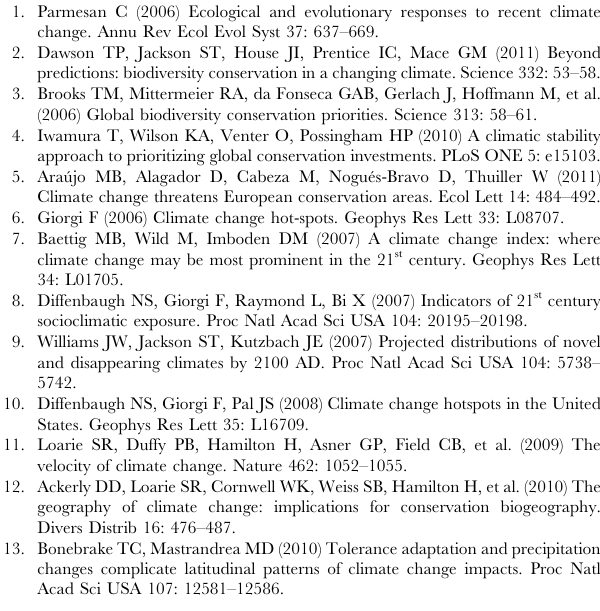
Table S2 Observed and projected RCCI for 196 G200 ecoregions. The observed RCCI (RCCI obs ) is based on differences in climate conditions between 1961 2 1980 and 1991 2 2009, generated from Climate Research Unit (CRU) TS 3.1 datasets; the projected RCCI is based on differences in climate conditions between 1991 2 2010 and 2081 2 2100, generated from an ensemble of 62 GCM 6 GHG emission scenario combinations. The relative magnitude of projected RCCI is measured by the multi-model mean RCCI (RCCI mean ) and the proportions of GCM 6 GHG emission scenario combinations with RCCI $ 12 (the 50 th percentile of RCCI obs ) and RCCI $ 16 (the 80 th percentile of RCCI obs ), respectively (abbreviated as Fr.(RCCI $ 12) and Fr.(RCCI $ 16)). Table S3 Value of the factor n in the definition of the RCCI. Any change in each climatic factor is assigned an integer value ‘‘n’’ between 0 and 4 according to the absolute value of change. Note that small changes below a certain threshold do not contribute to the index (n= 0) and that larger changes are weighted more heavily (i.e., the factor n doubles from each category to the next). This table is adapted from Table 1 of Ref. Table S4 The ensemble of 23 General Circulation Models (GCMs) used in this study. Figures in brackets indicate the number of different realizations for a GCM 6 GHG emission scenario